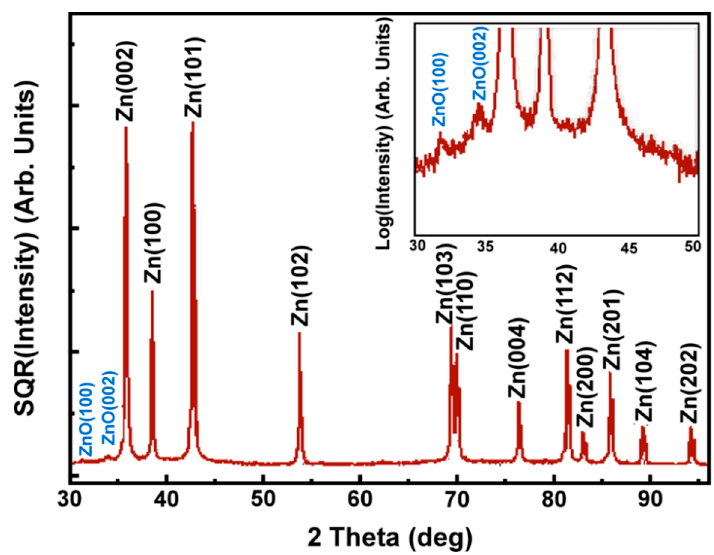
Figure 9. BB-XRD diffraction pattern of the polished samples grown by thermal spray. The inset Figure 9. BB-XRD di ff raction pattern of the polished samples grown by thermal spray. The inset pattern pattern is a zoom-in to the area of interest (ZnO peaks). is a zoom-in to the area of interest (ZnO